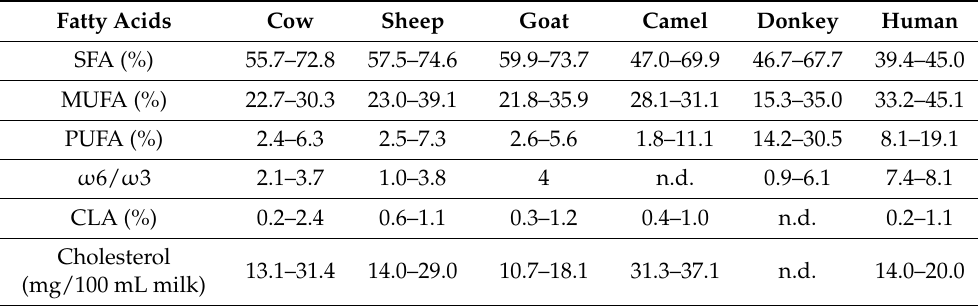
Table 4. Fatty acid profile (% of total fatty acids) and cholesterol content in milk of different mam- malian species.